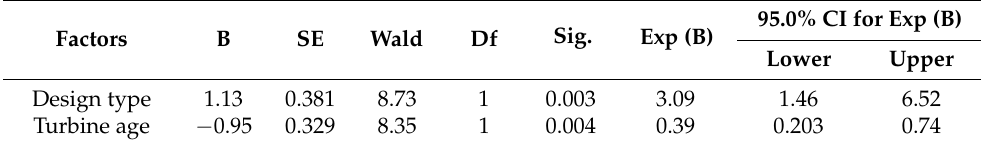
Figure 5. Kaplan–Meier survival functions for fuses based on the operational, climatic and geographic factors. ( a ) Design type ( b ) Climatic regions( c ) Turbine age ( d ) Distance to coast ( e ) Elevational location ( f ) MAWS ( g ) NOPF. Table 9. Cox regression results for